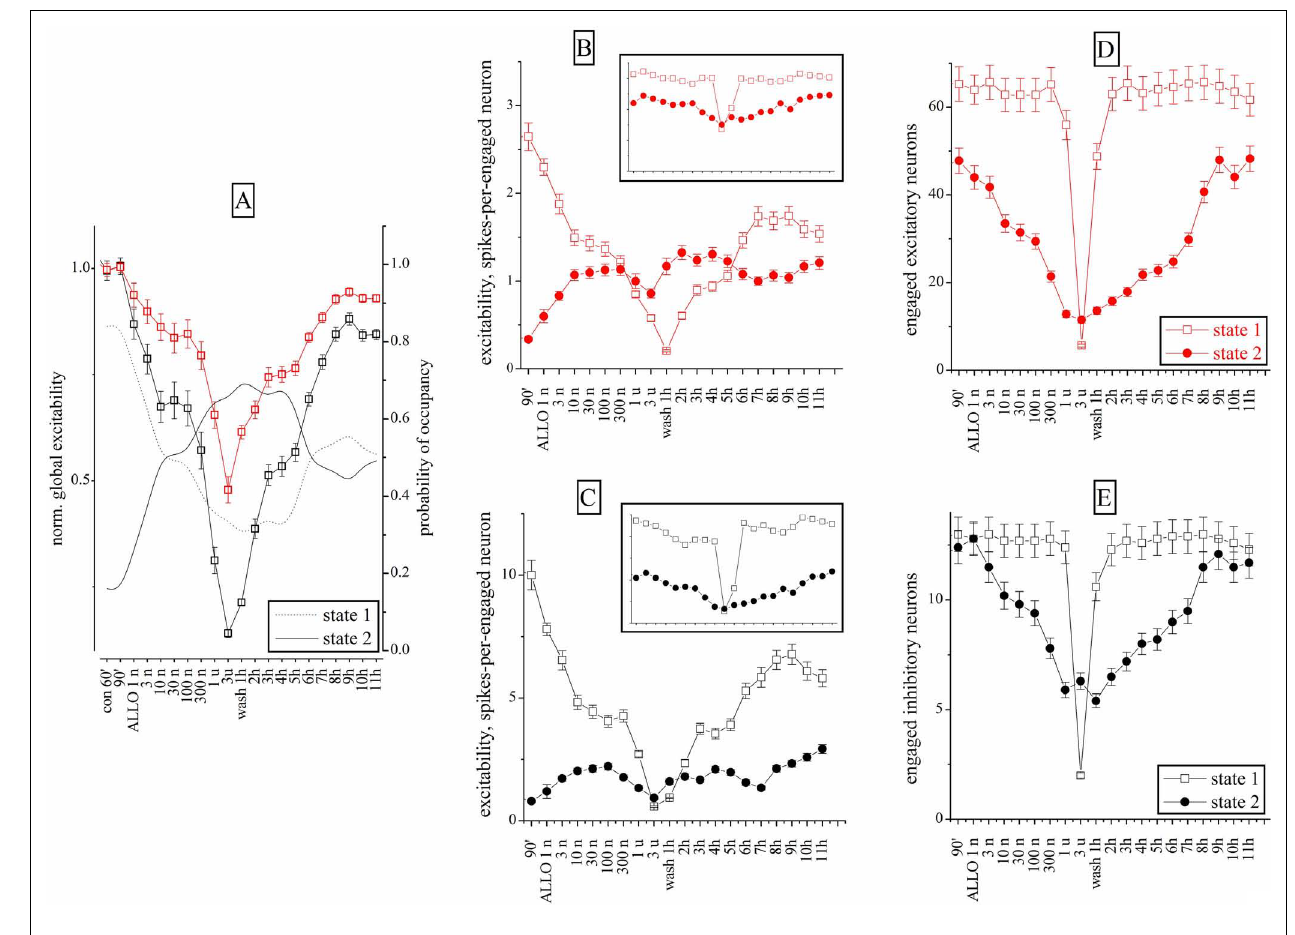
FIGURE 6 | Excitability and engaged neurons from “global” and “state” data analysis duringALLO dose–response experiments compared to control. (A) Normalized global excitability dose–response curves for clusters of excitatory (red) and inhibitory (black) neurons during a long experiment. Superimposed lines show PO values for state 1 and 2 as indicated (right y -axis). (B,D) Excitability and number of engaged neurons for the excitatory cluster in the state 1 (open square) and 2 (closed circles). Inset: plots of the same data (same scales) but without taking into account the